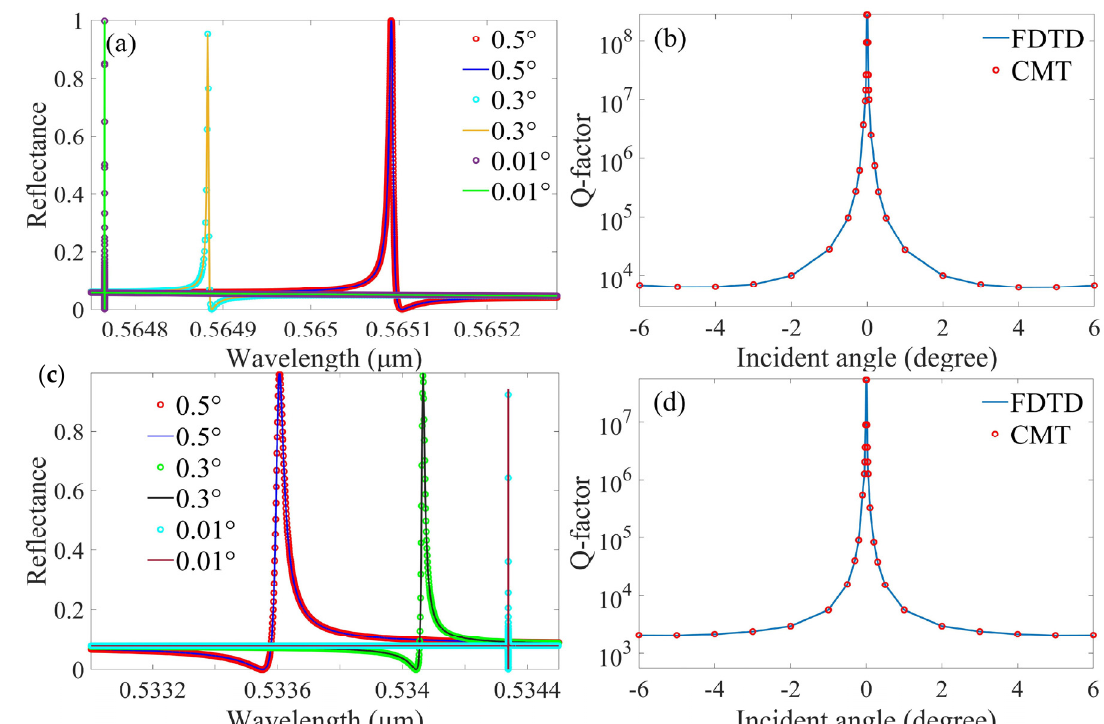
Figure 3. The reflectance spectra of the metasurface extracted from Figure 2 simulated from FDTD (solid lines) and temporal CMT (circle dots) at the incidence angle ( a ) θ = 0.01°, 0.3°, 0.5°, around λ = 0.5647652 µm, ( c ) θ = 0.01°, 0.3°, 0.5°, around λ = 0.534339 µm, respectively. ( b , d ) are the different variations of the Q-factors of ( a , c ) reflectance resonance modes, including FDTD simulations of BIC (solid line) and CMT calculations (dots) at di ff erent incidence angles, respectively.